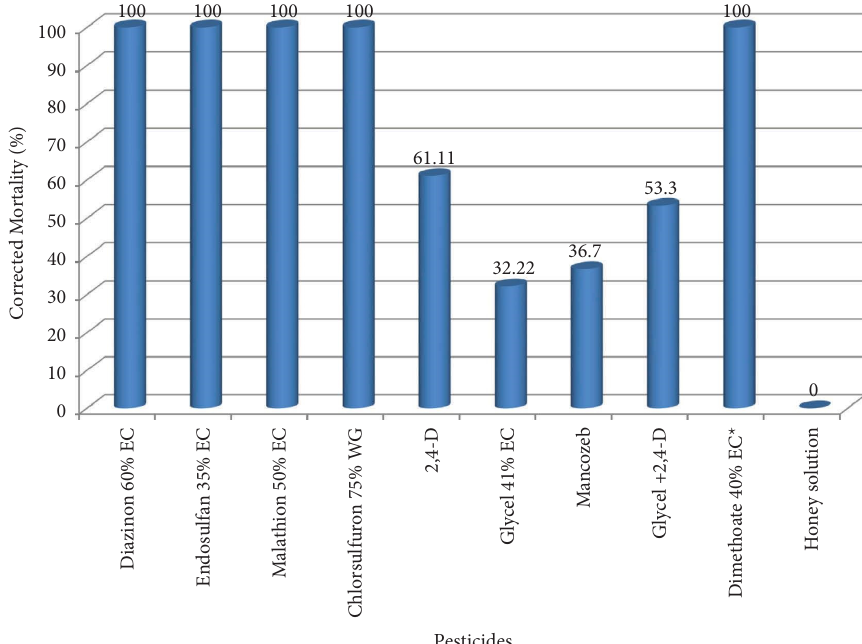
Figure 2: Mortality of local bees ( A. m. jemenitica ) tested via